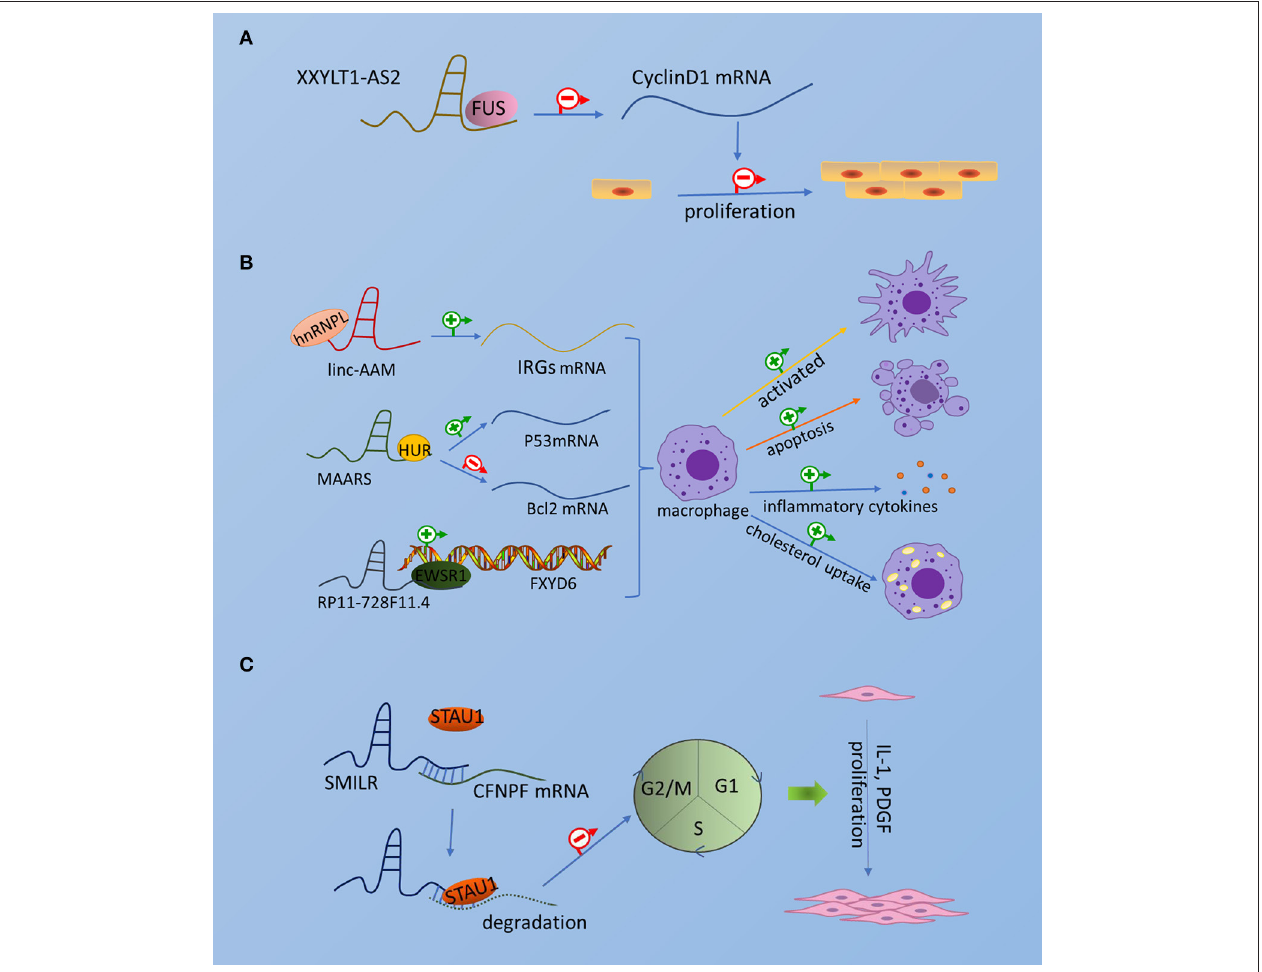
FIGURE 1 | The interaction of lncRNA and RBP in atherosclerosis. The picture schematically represents the interaction of emerging RBPs and lncRNAs in atherosclerotic endothelial cells, smooth muscle cells, and macrophages. (A) Endothelial cells. (B) Smooth muscle cells. (C)